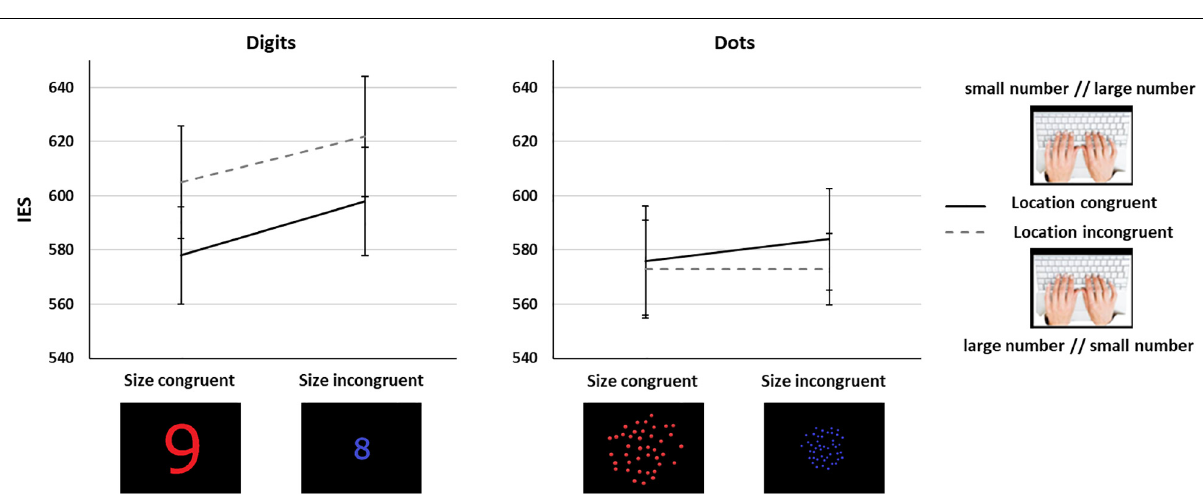
FIGURE 3 | Interaction between number/location and number/spatial extent mappings in Experiment 1 for the symbolic (left) and the non-symbolic (right) tasks. Error bars show standard error of the mean